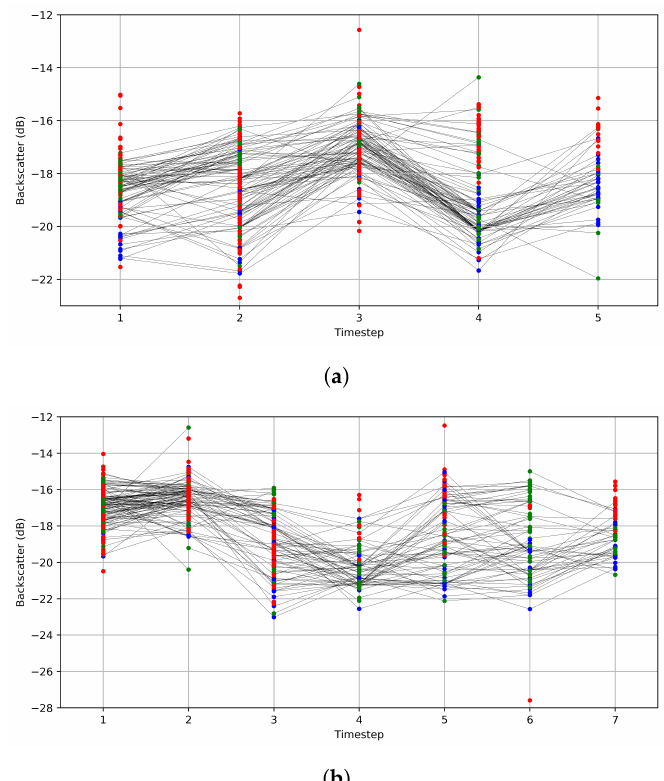
Figure 7. Global temporal profiles for VV polarisations. Unconnected polygons (red nodes), temporary entities (green nodes), and permanent entities (blue nodes). ( a ) Ascending time series VV polarisation. ( b ) Descending time series VV